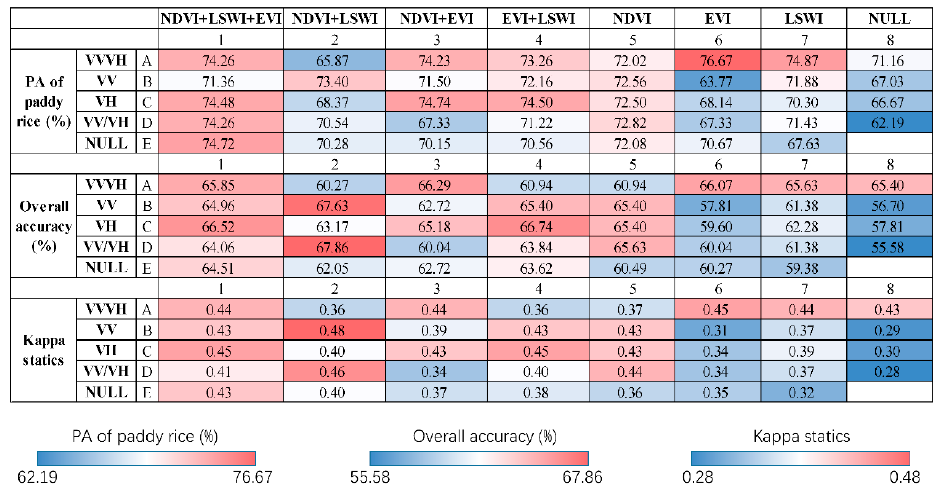
Table 3. Combination of the dataset used in this study.